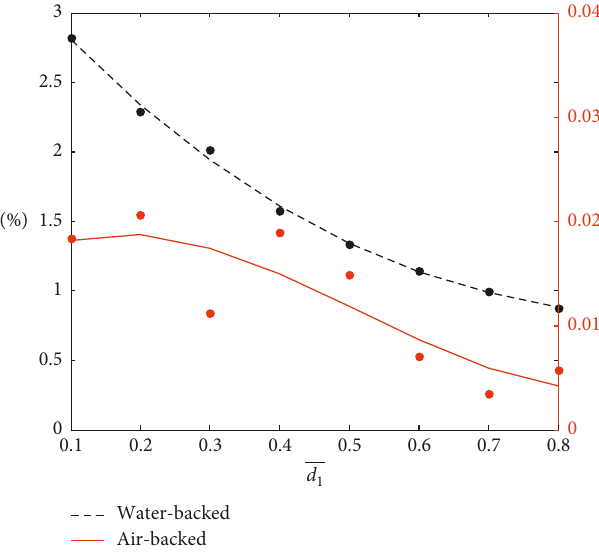
Figure 21: The total transmission energy for different outer shell thicknesses. The water-backed case is plotted in the left axis, and the air-backed case is plotted in the right axis.